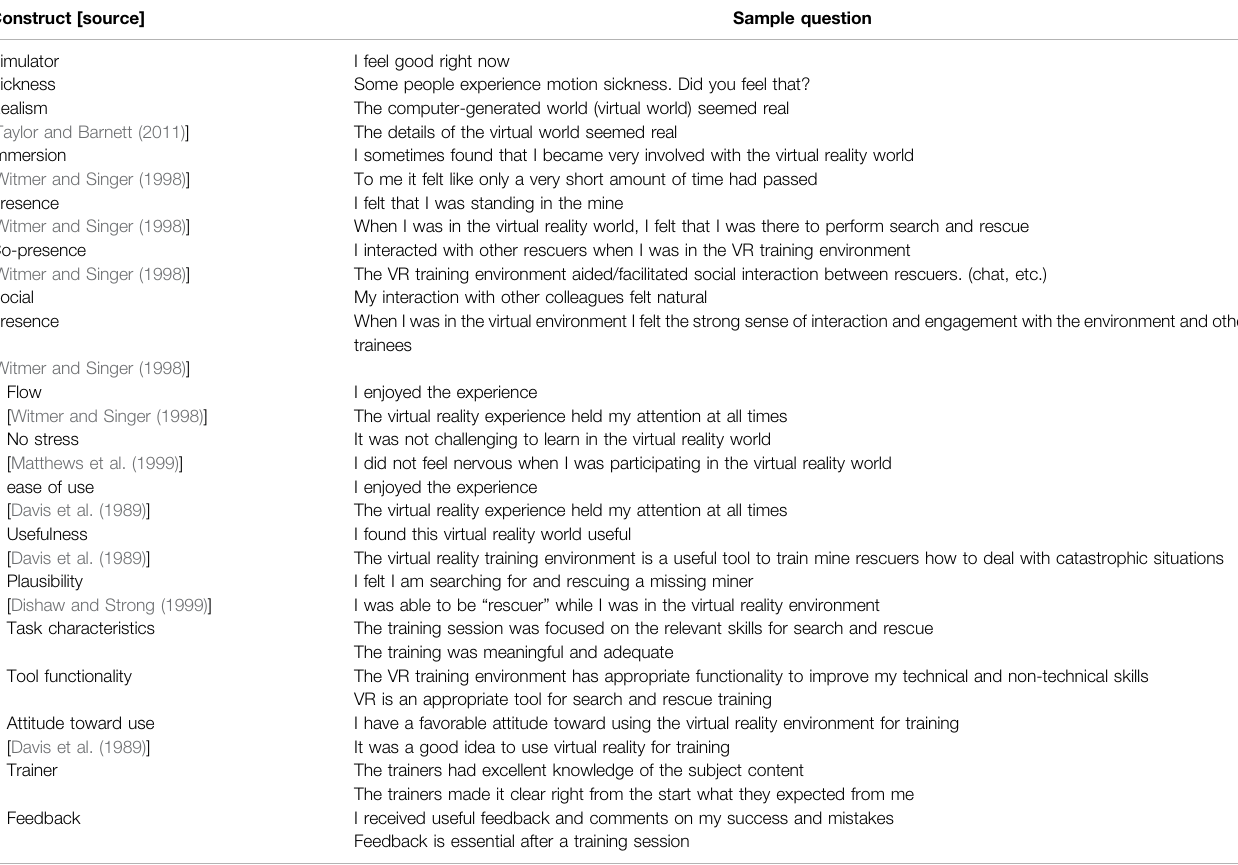
TABLE 5 | Post-experience questionnaire.